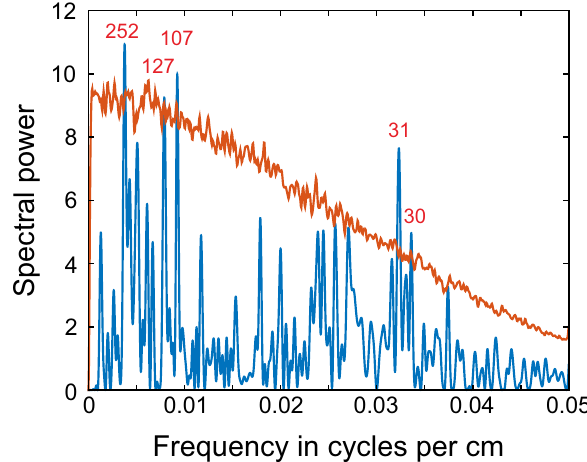
Figure 3. Spectral analysis of the depth series of magnetic suscep- tibility data of the Youganwo oil shale. The analysis reveals domi- nant sedimentary cycles with cycle wavelength ratios similar to pe- riodicity ratios of orbital cycles, suggesting that these sedimentary cycles probably represent orbital cycles. The red curve represents the noise level above which the spectral peaks are considered sta- tistically significant. The numbers above the spectral peaks indicate cycle wavelengths (in centimeters) of the sedimentary cycles. See text for